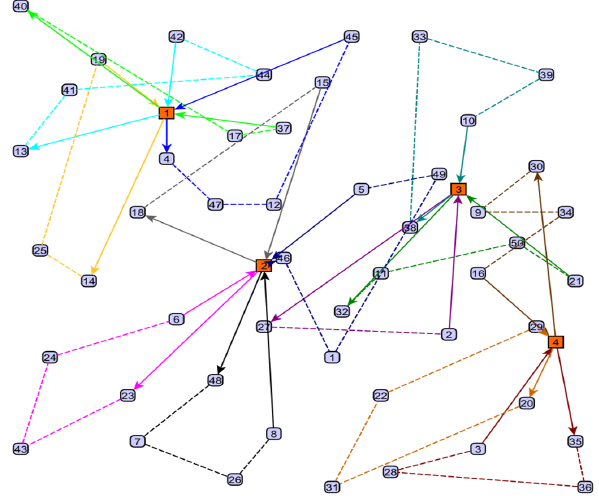
Fig. 3. Solution for the instance P01 min fo